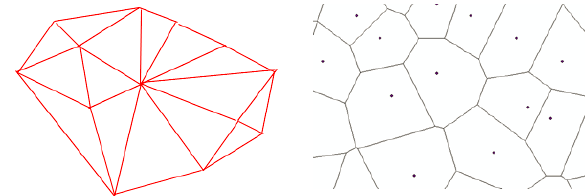
Figure 16. Construction of a Thiessen